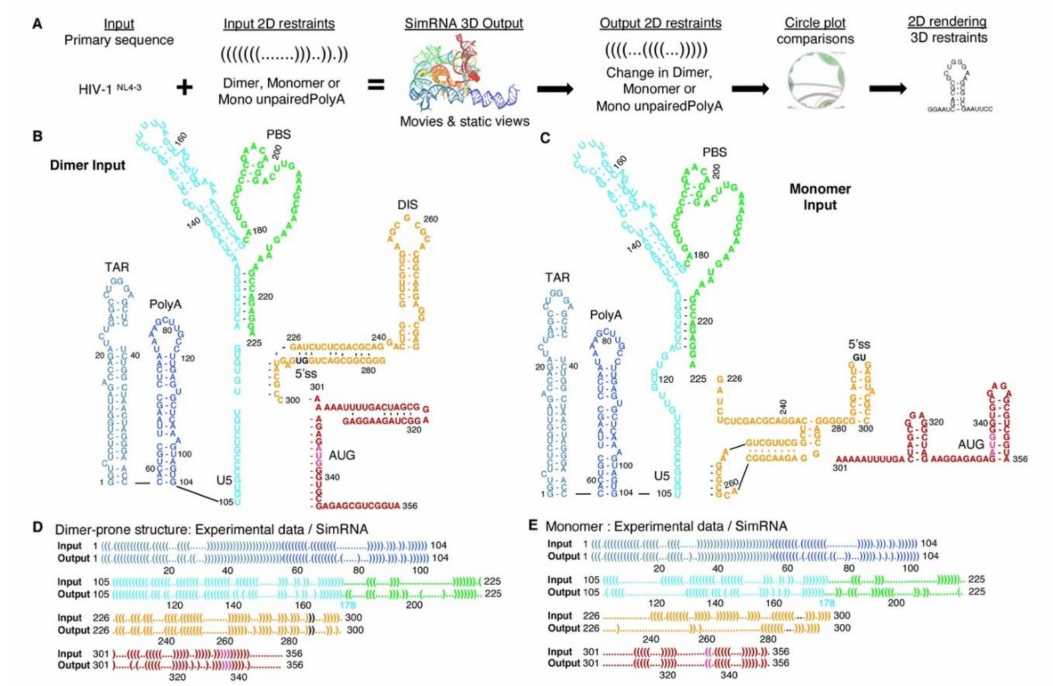
Figure 1. Approach to generate tertiary structure models of the HIV NL4-3 5 (cid:48) -UTR. ( A ) Workflow used to process the tertiary structure predictions by SimRNA from experimentally determined models expressed in the Vienna dot-bracket language. ( B ) Input Dimer secondary structure input to SimRNA. ( C ) Comparison of the Input and Output structures in the Vienna dot-bracket language. ( D ) Monomer secondary structure input to SimRNA. ( E ) Comparison of the experimental Input constraints and SimRNA Output models in the Vienna dot-bracket language. Label colors designate: TAR, light blue; PolyA stem, navy; U5 stem, cyan; PBS, green; DIS and 3-way junction, orange; AUG stem, red; 5 (cid:48) -splice site (5 (cid:48) ss), black; gag start codon,